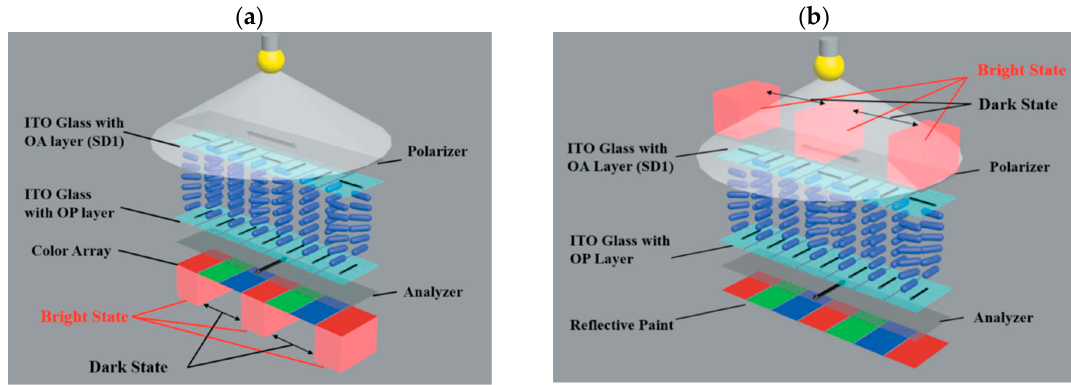
Figure 7. ( a ) Schematic representation of optically driven LCD. ( b ) Optically driven LCD with patterned reflective paint [45].